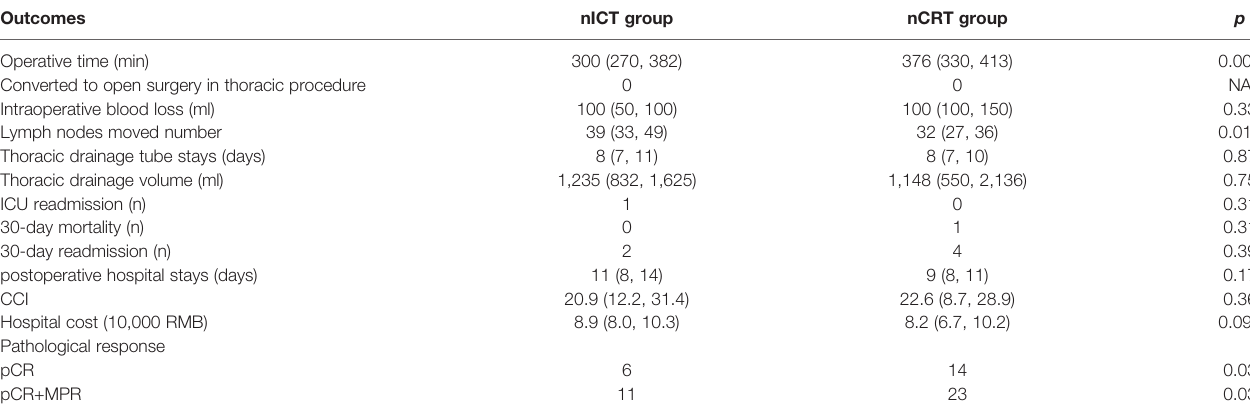
TABLE 2 | Perioperative outcomes after propensity score